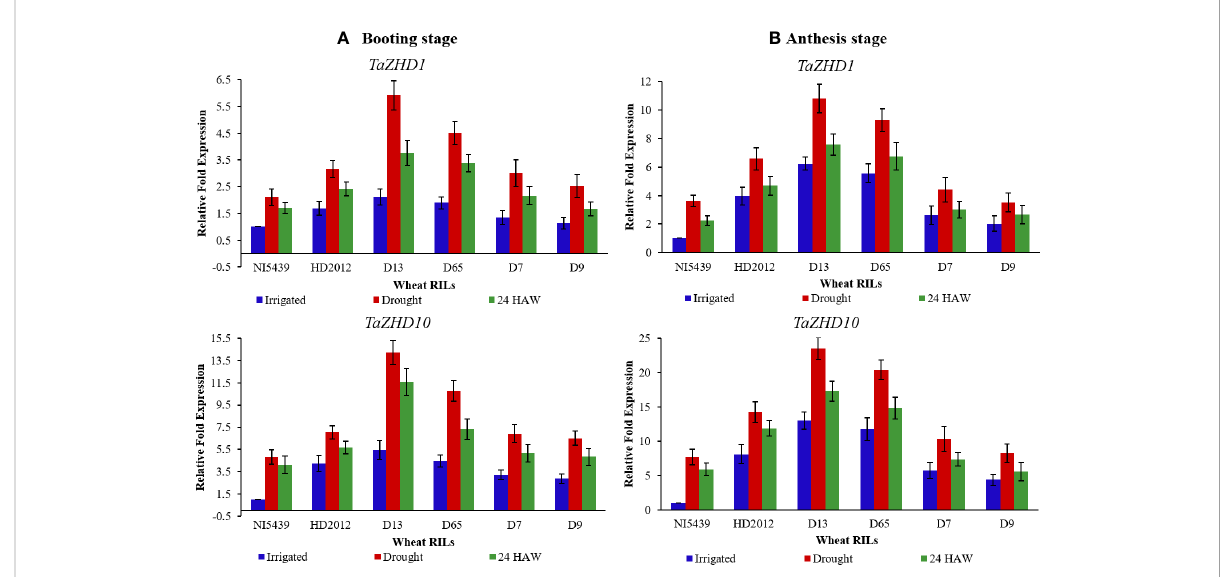
FIGURE 8 Relative expression pro fi ling of candidate leaf rolling ZHD genes in tissues of wheat RILs at (A) booting stage, and (B) anthesis (heading) stage (From left to right: NI5439; drought resilient, HD2012; drought susceptible, high LR RILs = D-13 and D-65, and low LR RILs = D-7 and D-9; HAW, hours after watering). Each test sample represents three independent biological and three technical